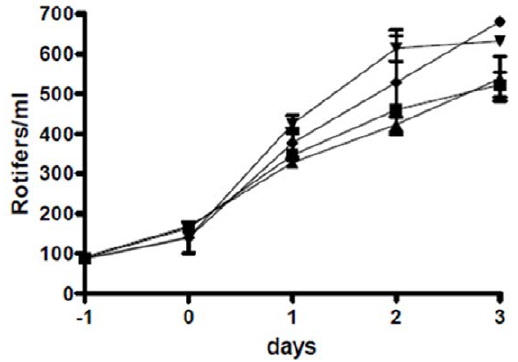
Figure 6. Reduction of Vibrio anguillarum by Phaeobacter gallaeciensis in rotifer cultures. Mean values of two duplicate experiments: colony-forming units of V. anguillarum in co-culture with P. gallaeciensis wild type ( m ), with the TDA-negative mutant of P. gallaeciensis ( . ), and in the monoxenic control ( & ).